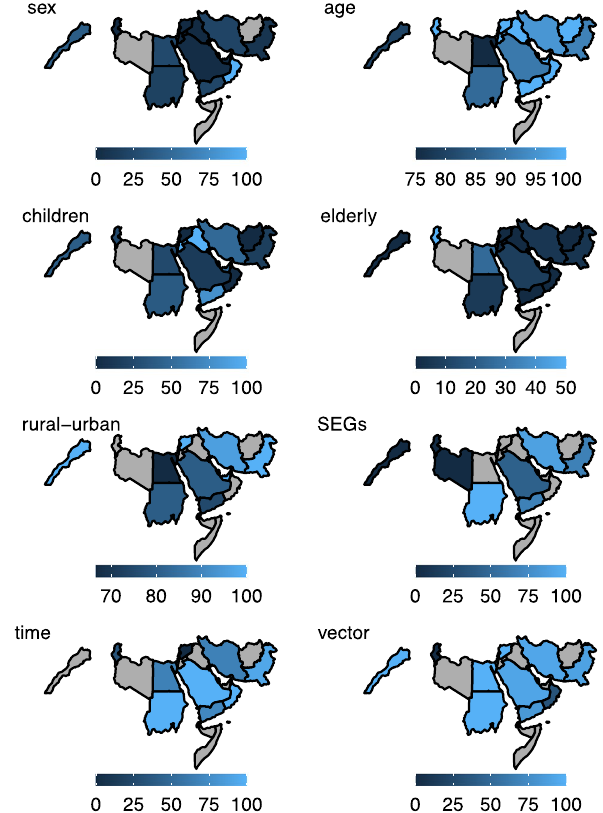
Fig. 2 Proportion of papers that reported differences in key epidemio- logical features of vector-borne and zoonotic diseases in the Eastern Mediterranean region. Note: the map (1, sex) refers to proportion of papers that reported higher morbidity among female, (2, age) shows proportion of papers that reported significant differences across age groups, (3, children) shows proportion of papers that reported signifi- cantly higher morbidity among children, (4, elderly) shows proportion of papers that reported significantly higher morbidity among elderly, (5, rural–urban) shows proportion of papers that reported significant differences across rural and urban areas, (6, SEGs) shows proportion of papers that reported significantly higher burden among poor socio- economic groups (SEGs), (7, time) shows proportion of papers that reported significant increase in incidence/prevalence over time, and (8, vector) shows proportion of papers that reported significantly high vector density among papers that had data for these variables. Maps were created using R software ggplot2 package. Light gray indicates no data were